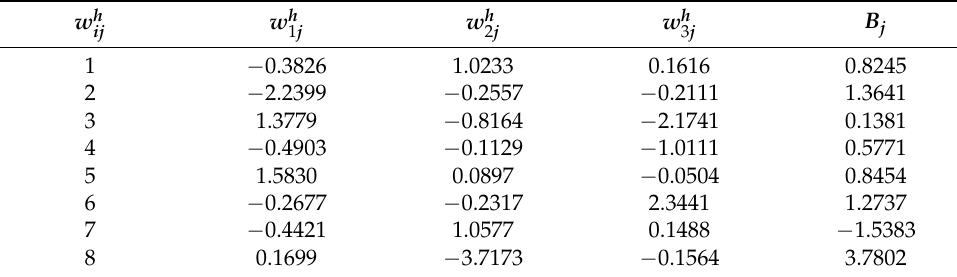
Table 3. Weights and bias for the CFIR drying of